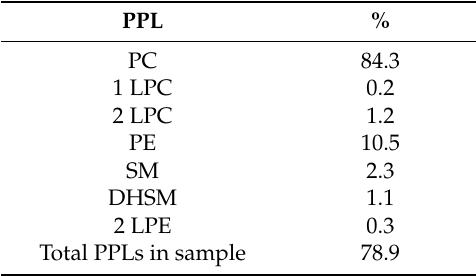
Table 2. PPLs composition of egg yolk lecithin used in SFC